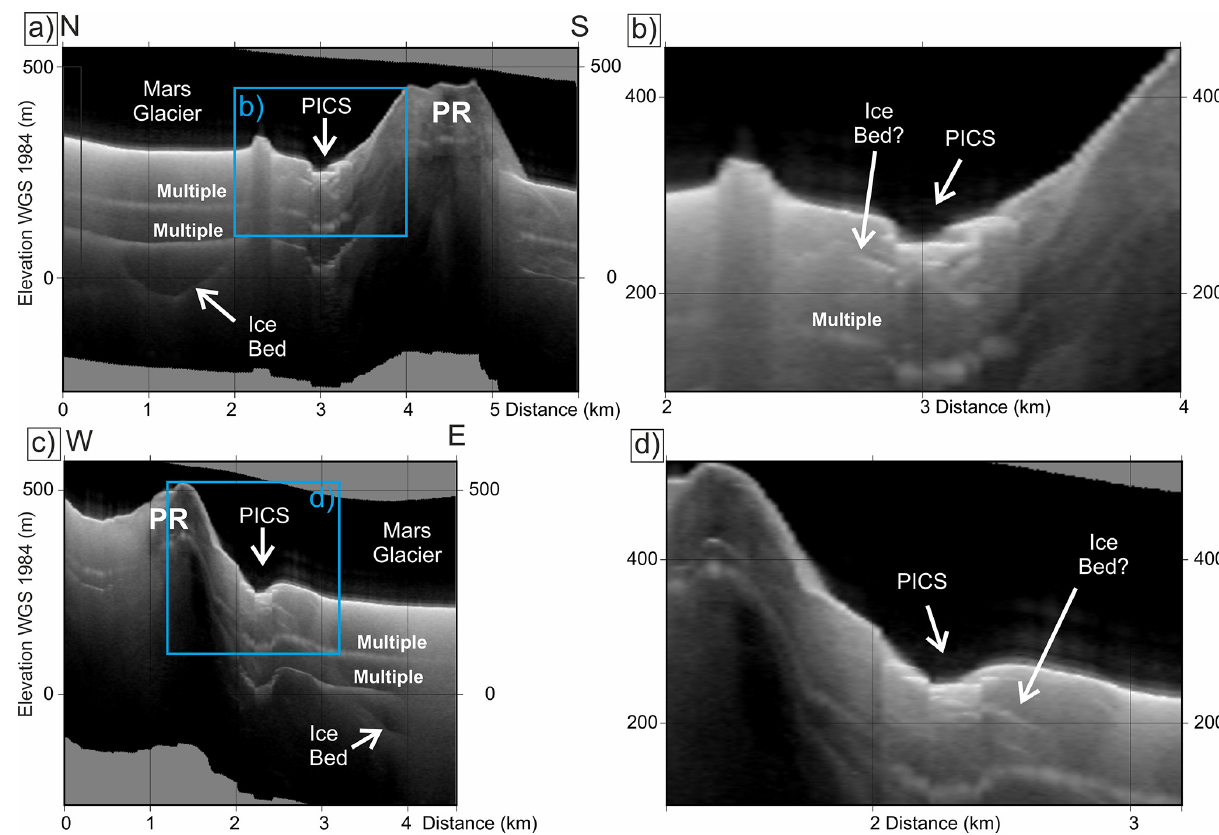
Figure 4. Radar sections along the red flight lines shown in Fig. 1b. (a) North to south section crossing Mars Glacier and Phobos Ridge (PR). Note ice-bed reflection ∼ 350m below the surface of Mars Glacier. (b) Detail of the north to south section over PICS (located by the blue box in panel a ). Note potential ice-bed reflection between 35 and 50m beneath the ice surface. (c) West to east section. (d) Detail of PICS on the west to east section (located by the blue box in panel c ). Image brightness indicates strength of the returned reflection on a log